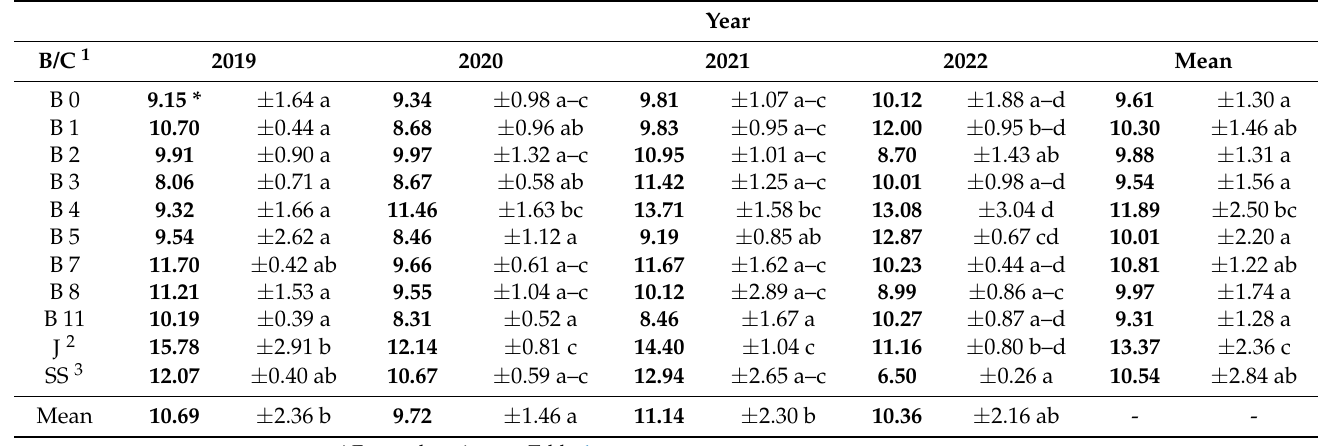
Table 10. Fruit-to-seed weight ratios of biotypes and cultivars.